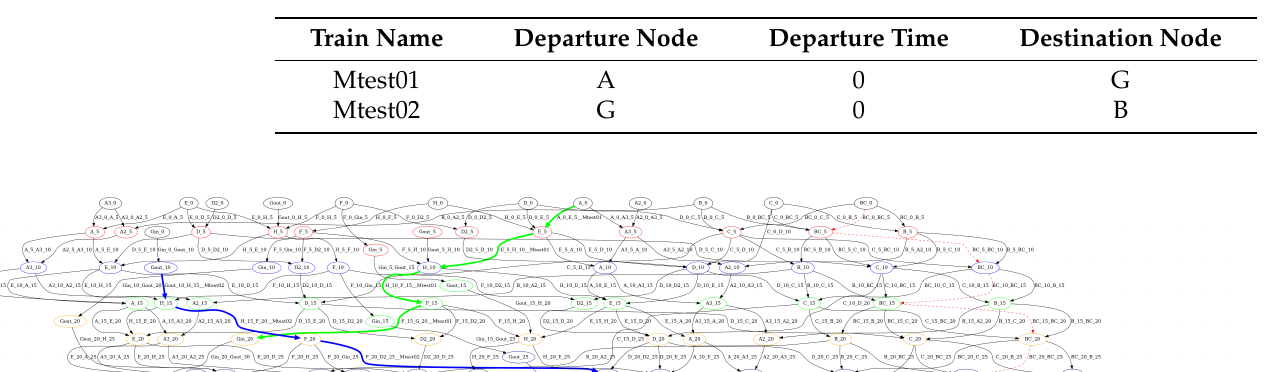
Table 4. Case 2: Train information.